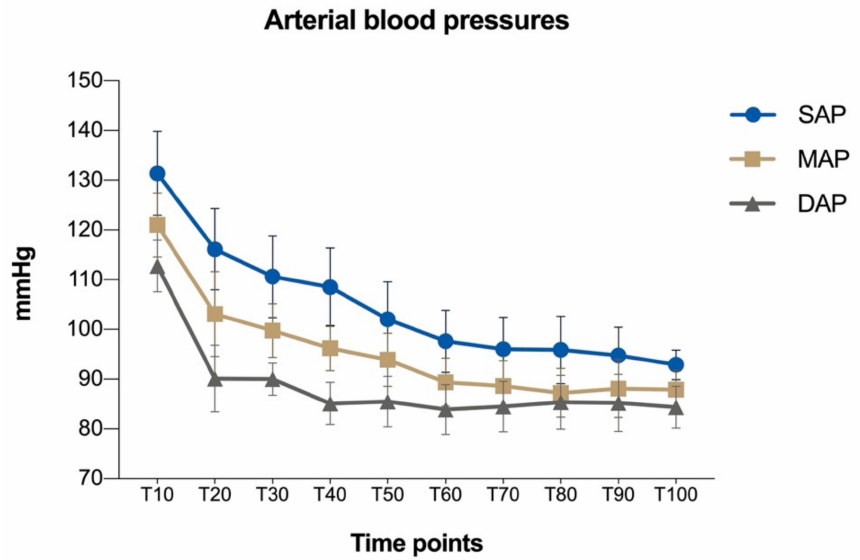
Figure 2. Mean values ± standard deviation of invasive systolic (SAP), mean (MAP) and diastolic (DAP) arterial blood pressures (mmHg) during the study. Time points, T0: baseline; from T10 to T100: measurements from the start of the surgery until the end of the